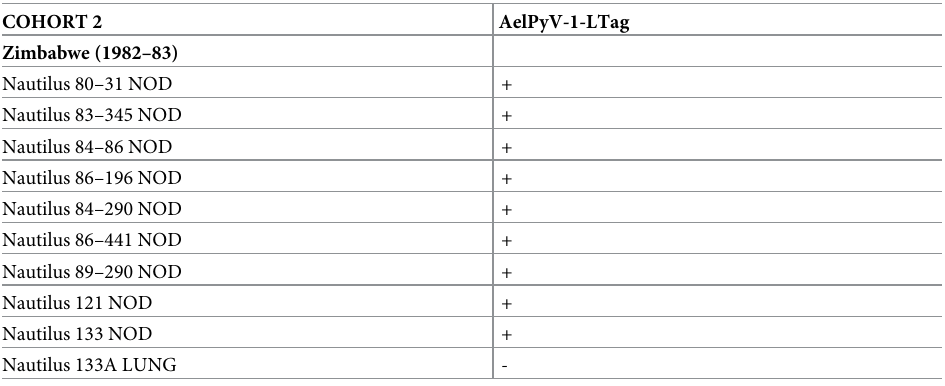
Table 3. FFPE Trunk nodule biopsies (preserved by Elliot Jacobsen,